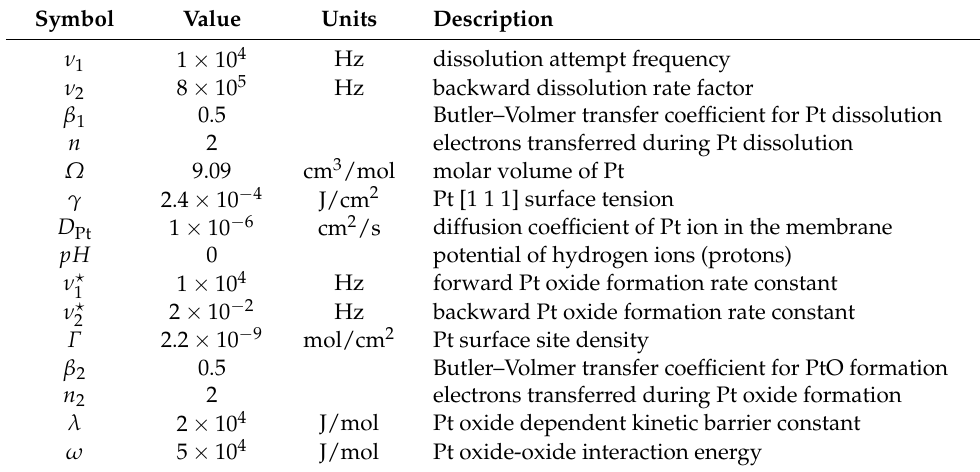
Table 2. Parameters for Pt ion formation and diffusion and Pt oxide formation.